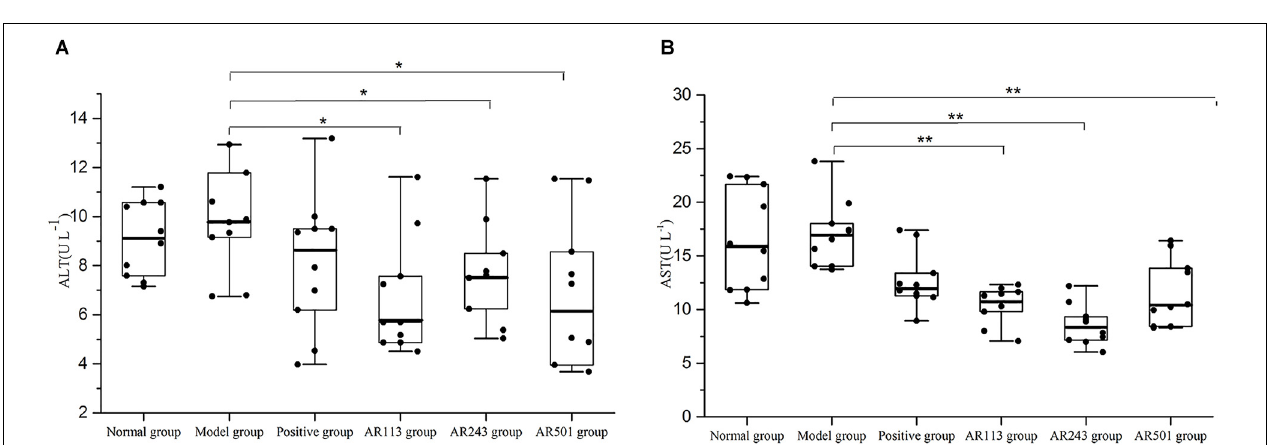
L. plantarum AR501, the activities of SOD and GSH-Px and T-AOC levels were significantly increased ( p < 0.01) compared to model group, confirming the antioxidative protection of the L. plantarum AR501. Feeding with P. pentosaceu s AR243 significantly increased the activities of GSH-Px and T-AOC ( p < 0.05) compared to feeding with normal saline. However, there were only SOD activity increased significantly in